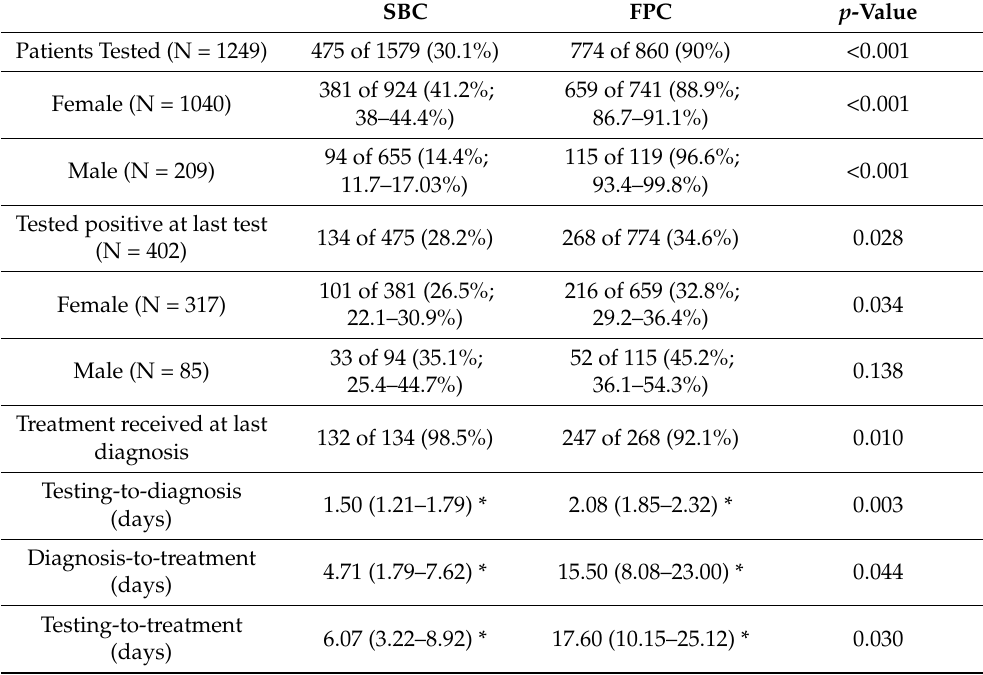
Table 2. Chlamydia and gonorrhea testing and treatment outcomes at last positive test (including pa- tients treated presumptively) for adolescents at school-based (SBC) and family planning clinics (FPC). SBC FPC p -Value Patients Tested (N =